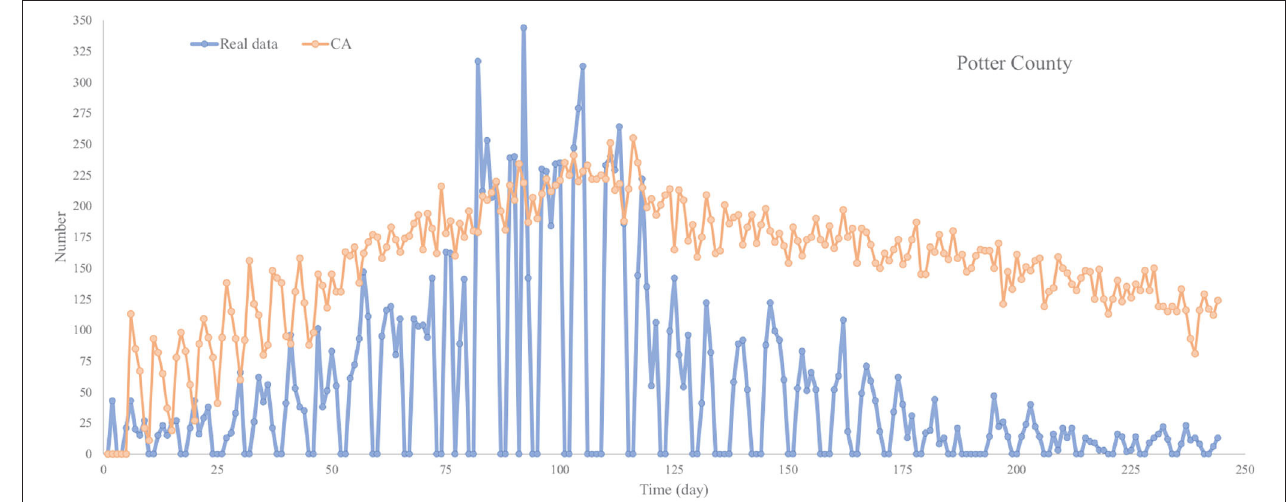
FIGURE 10 | Trend chart of daily confirmed cases of CA in Potter County.